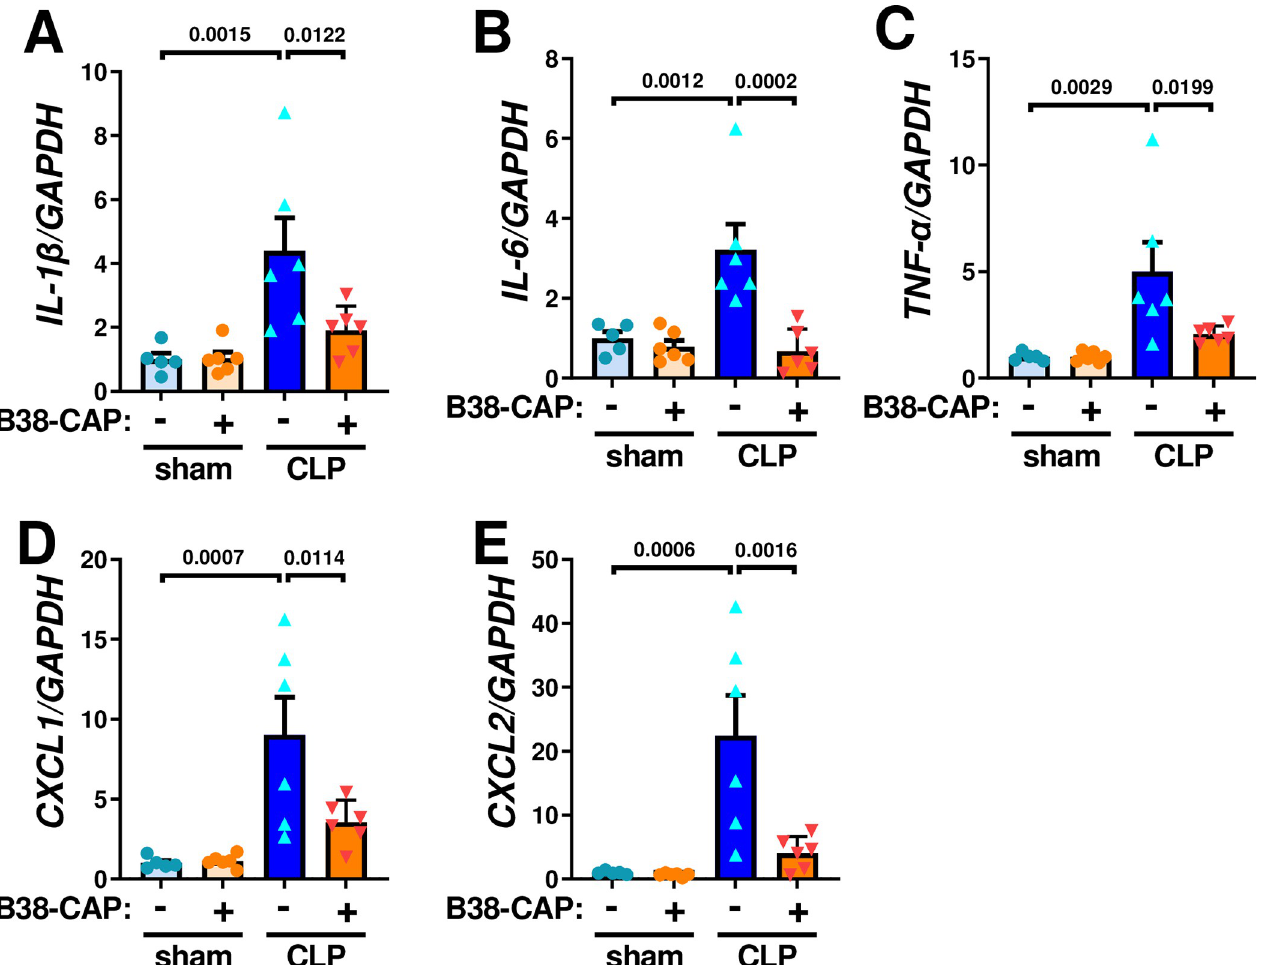
Fig 4. B38-CAP suppresses CLP-induced pulmonary pro-inflammatory cytokines. A–E , qRT-PCR analysis for the expression pro-inflammatory cytokine genes in the lungs; mRNA levels of interleukin 1 beta (IL-1 β ) ( A ), interleukin 6 (IL-6) ( B ), tumor necrosis factor alpha (TNF- α ) ( C ), CXCL1 ( D ) and CXCL2 ( E ) in the lungs of mice treated with sham + vehicle (n = 5), sham + B38-CAP (n = 6), CLP + vehicle (n = 6) and CLP + B38-CAP (n = 6). All values are means ± SEM. One-way ANOVA with Sidak’s multiple-comparisons test. Numbers above square brackets show significant P-values.